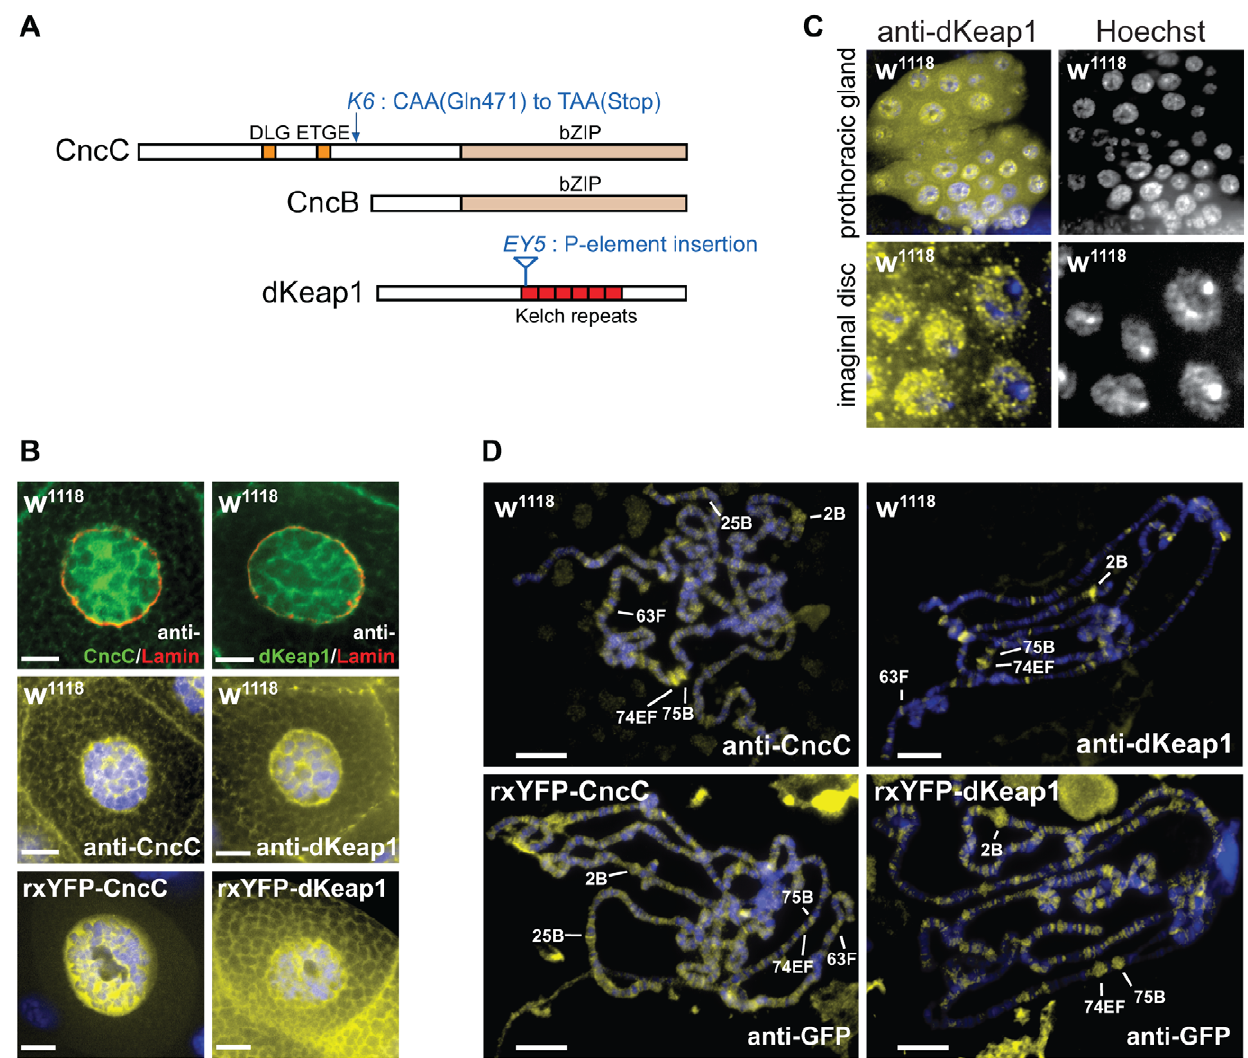
Figure 1. CncC and dKeap1 subcellular localization and polytene chromosome occupancy. (A). Conserved sequences and mutations in CncC, CncB and dKeap1. Regions that are conserved between Drosophila and mammalian proteins are shown in color. The locations of the cnc K6 and dKeap1 EY5 mutations are indicated [3,15]. (B). Visualization of the subcellular distributions of CncC and dKeap1 in salivary glands. [Upper panels] Endogenous CncC and dKeap1 distributions in wild type ( w 1118 ) salivary glands stained using anti-CncC or anti-dKeap1 (green) and anti-Lamin Dm0 (red) antibodies. [Middle panels] Wild type ( w 1118 ) salivary glands were stained with anti-CncC or anti-dKeap1 antibodies (yellow) and Hoechst (blue). [Lower panels] Ectopic CncC and dKeap1 distributions in live salivary glands that expressed rxYFP-CncC and rxYFP-dKeap1, respectively. The intrinsic fluorescence (yellow) was superimposed on Hoechst fluorescence (blue). The salivary glands were isolated from early wandering 3 rd instar larvae. The scale bars are 10 m m. (C). Visualization of the localization of endogenous dKeap1 in the prothoracic gland and in imaginal disc cells. Endogenous dKeap1 was visualized by immunostaining using anti-dKeap1 antibodies (yellow) superimposed on Hoechst staining (blue). The separate images are shown to the right of each color image. (D). Visualization of the loci occupied by CncC and dKeap1 on polytene chromosomes. [Upper panels] The loci occupied by endogenous CncC and dKeap1 were visualized on polytene chromosome from wild type larvae ( w 1118 ) by staining with anti-CncC and anti-dKeap1 antibodies, respectively. [Lower panels] The loci occupied by ectopic CncC and dKeap1 were visualized on polytene chromosomes from larvae that expressed rxYFP-CncC and rxYFP-dKeap1, respectively, by staining with anti-GFP antibodies. The immunofluorescence (yellow) was superimposed on Hoechst fluorescence (blue). The major ecdysone-regulated early puffs are indicated. The polytene chromosomes were prepared from the salivary glands of early wandering 3 rd instar larvae.